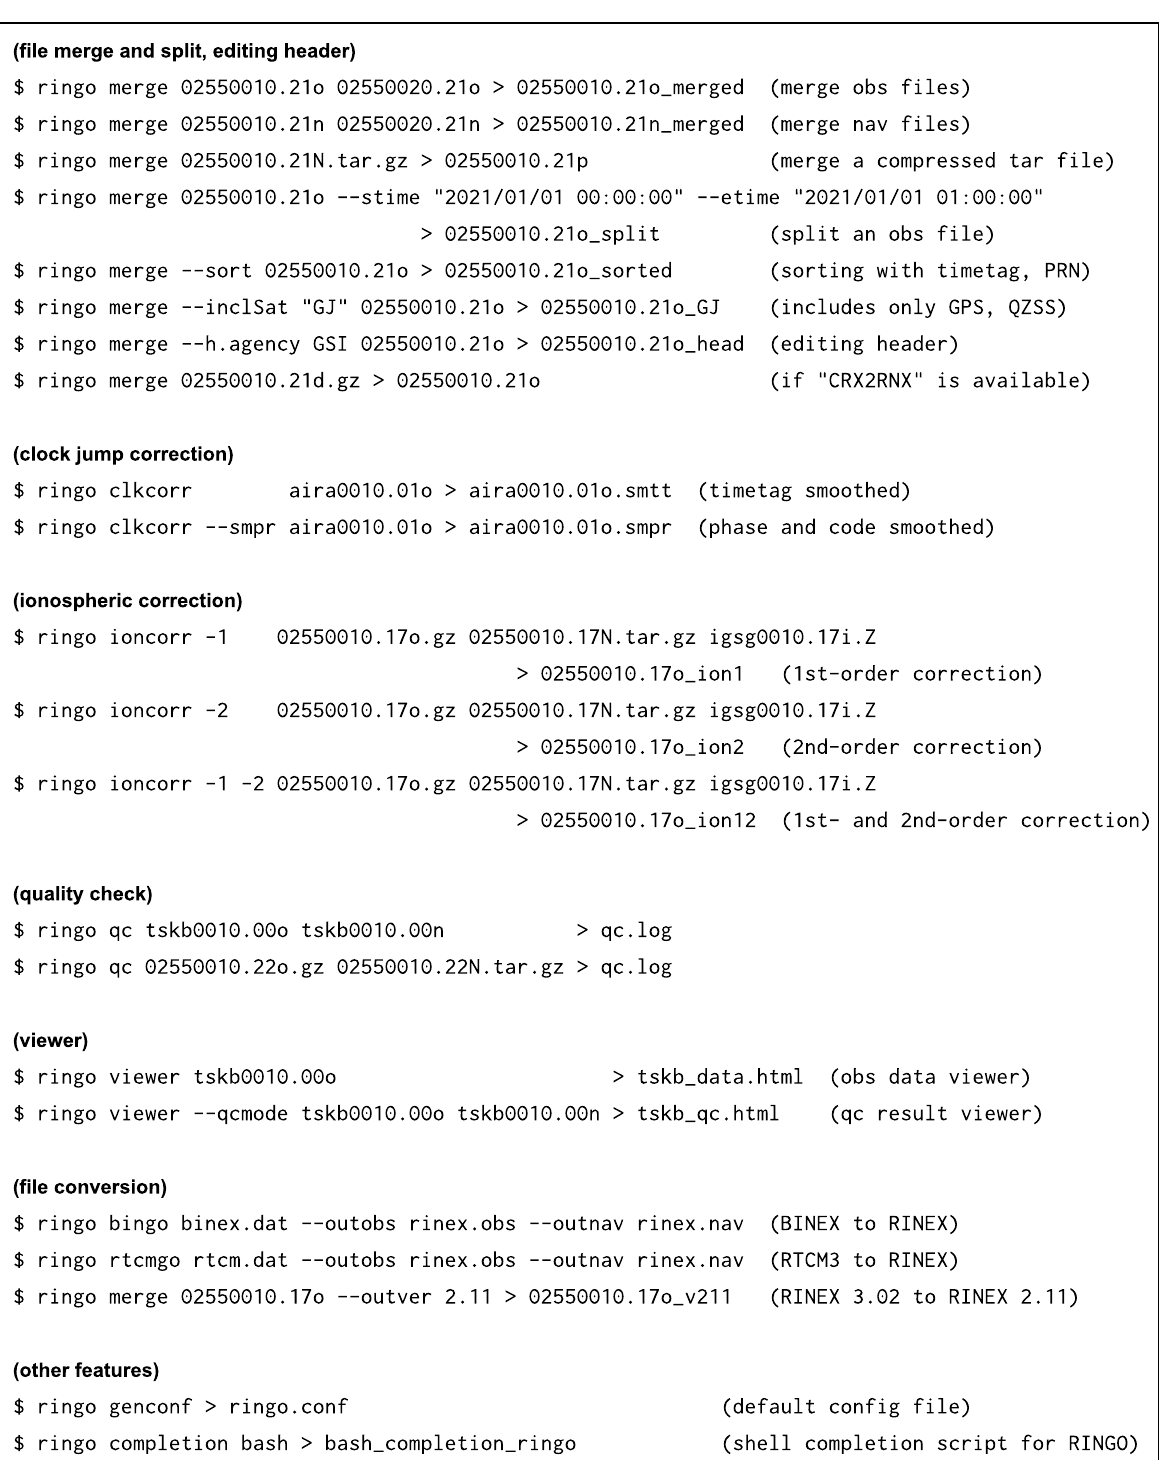
Fig. 1 Examples of RINGO execution